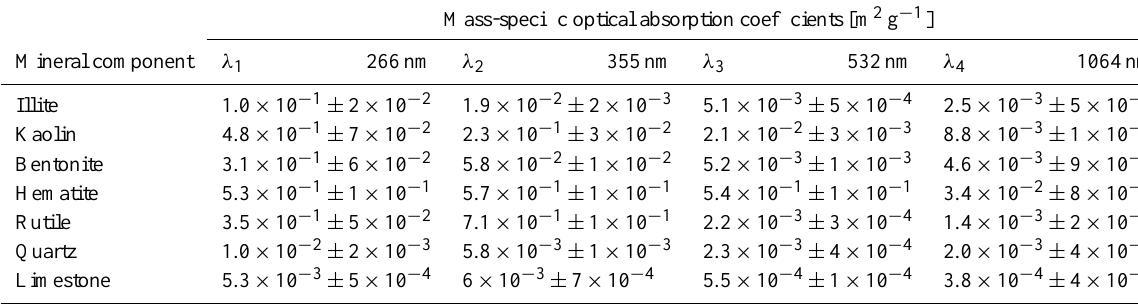
Table 1. Mass-specific optical absorption coefficients of the measured MD components.